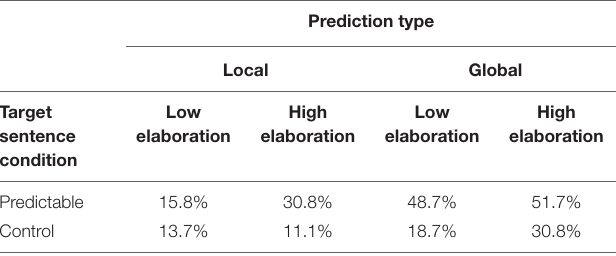
TABLE 2 | Percentage of target words generated in CWS